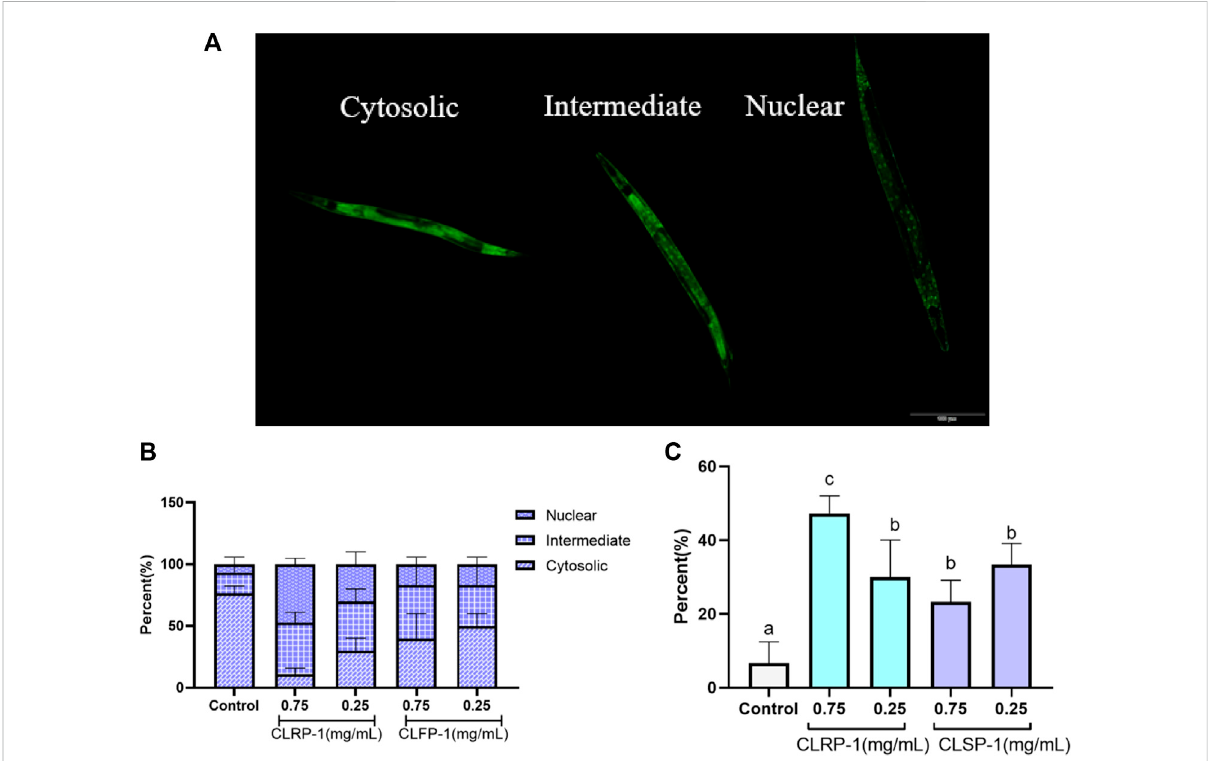
FIGURE 7 Effect of CLRP-1 and CLSP-1 on the transcription factor of DAF-16 under thermal stress. (A) The localization of transcription factor of DAF-16. (B) The localization of DAF-16. (C) The percentage of nuclear localization. Bars with different lowercase letters (a – c) are signi fi cantly different ( p <